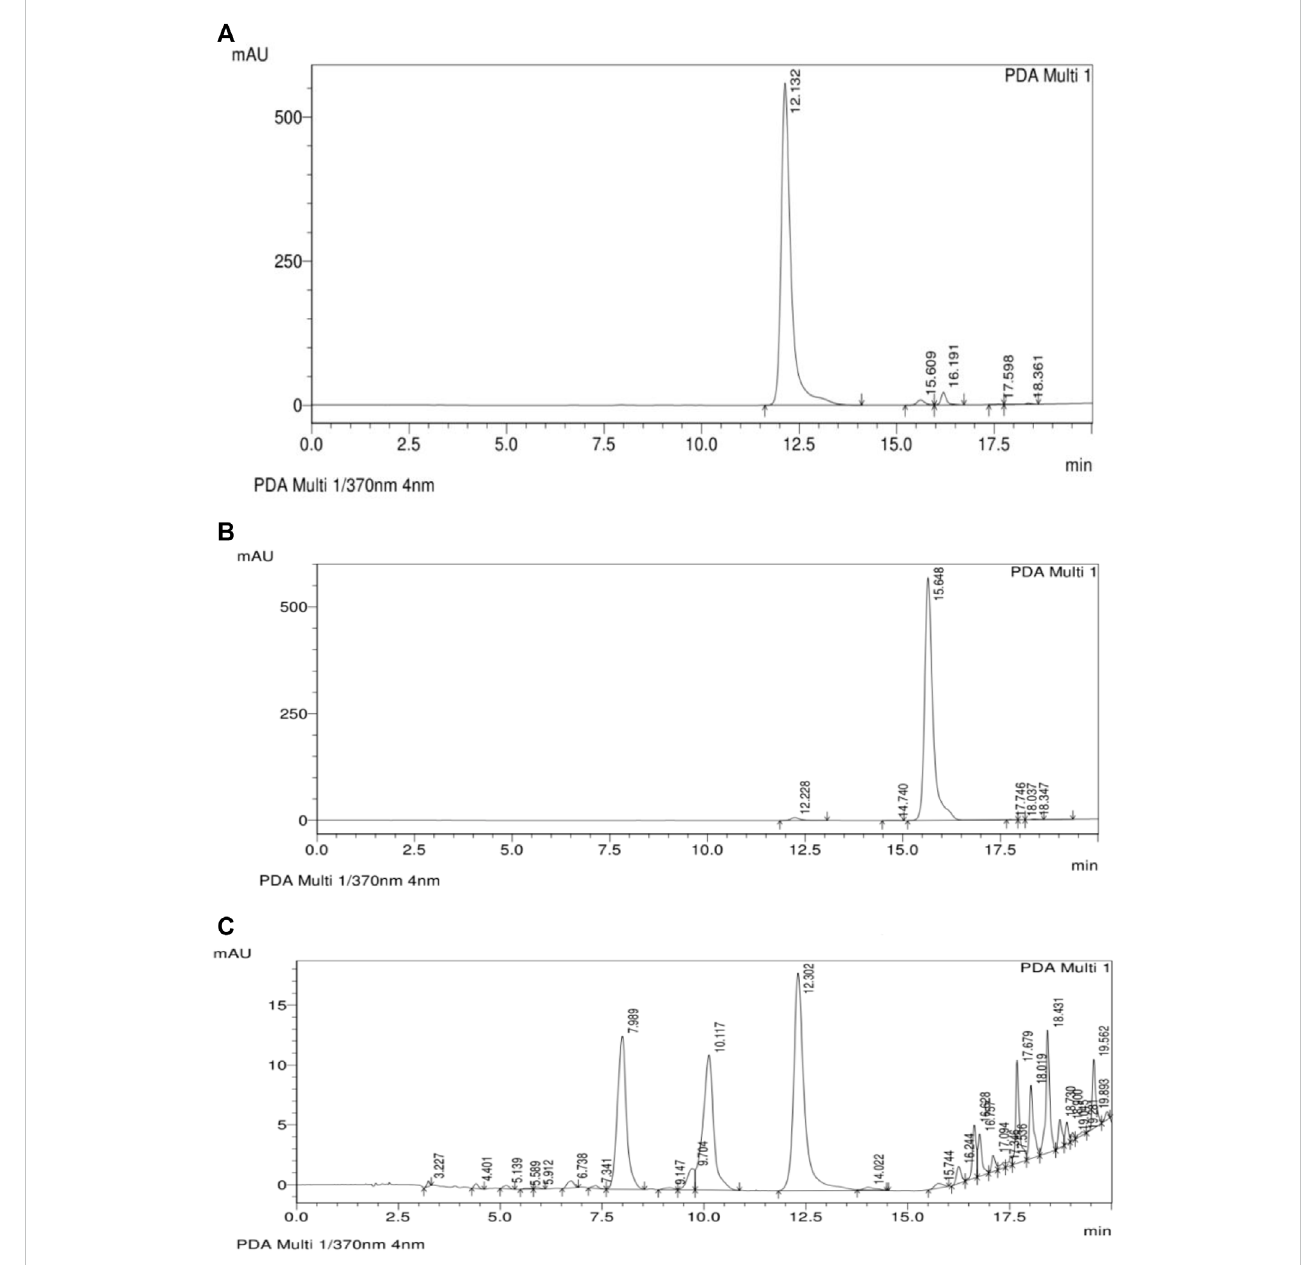
FIGURE 3 HPLC analysis of ethyl acetate fraction of (A) Quercetin, (B) Kaempferol and (C) Ethyl acetate fraction of D.